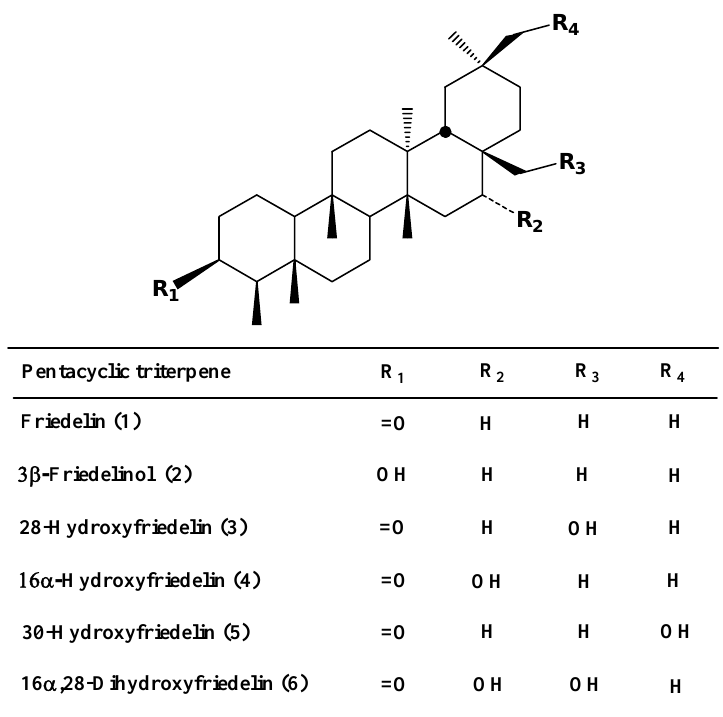
Figure 1 . Pentacyclic triterpenes isolated from Salacia elliptica